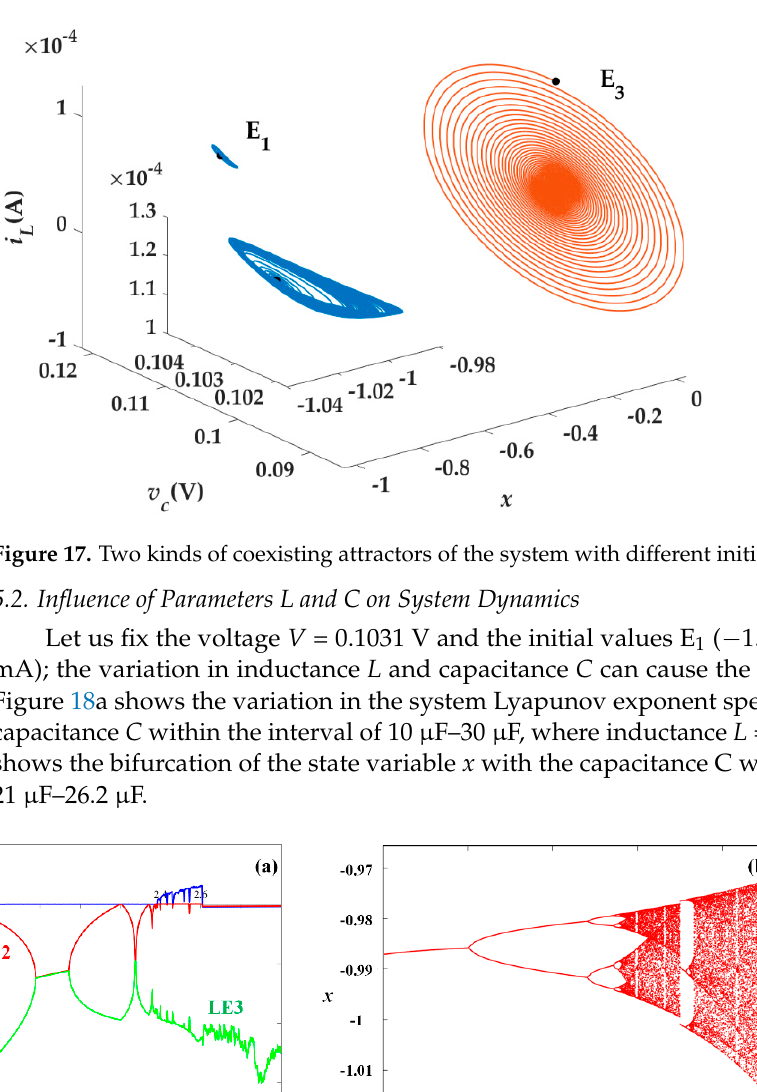
Figure 19. Variation in system attractor with capacitance C , where V = 0.1031 V, L = 0.96 H. ( a ) C = 21.5 μ F, ( b ) C = 23 μ F, ( c ) C = 23.8 μ F, ( d ) C = 26 μ F.